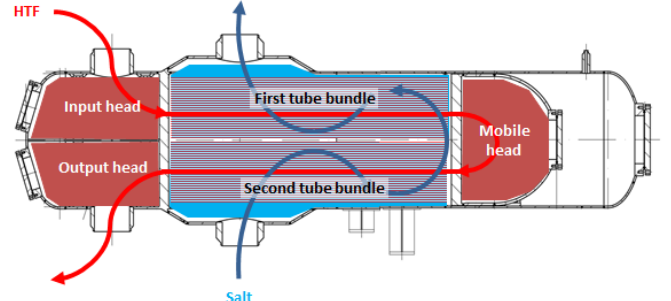
Figure 8. Components of an HTF-Salt heat